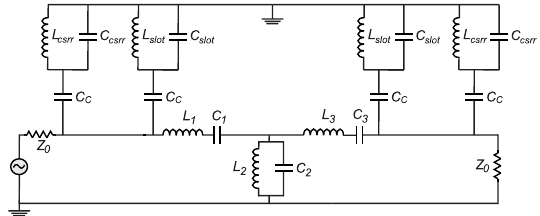
Figure 7: Equivalent circuit model with two CSRR and slot-loaded in the ground and the transmission lines respec-